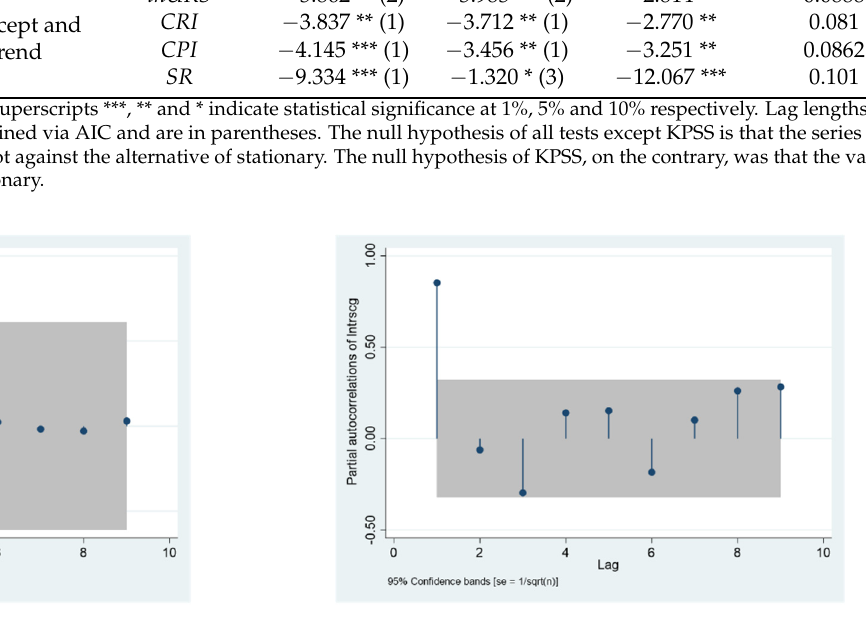
Figure 1. ACF and PACF diagram of lnURS